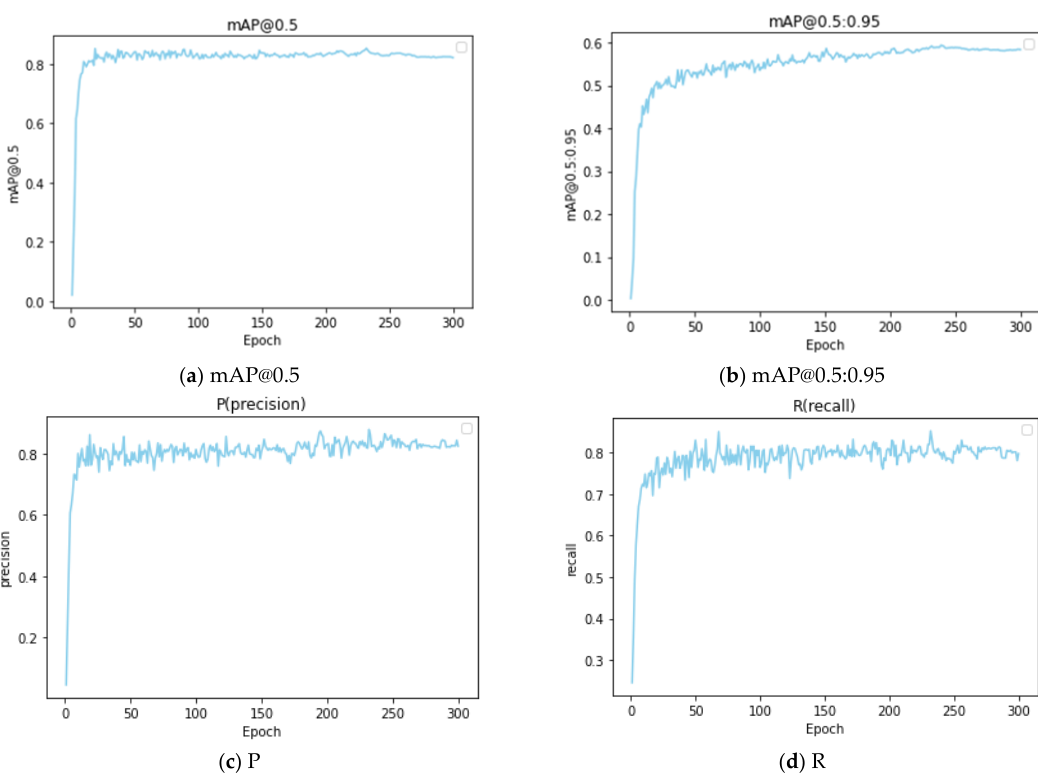
Figure 14. Convergence process of evaluation index.